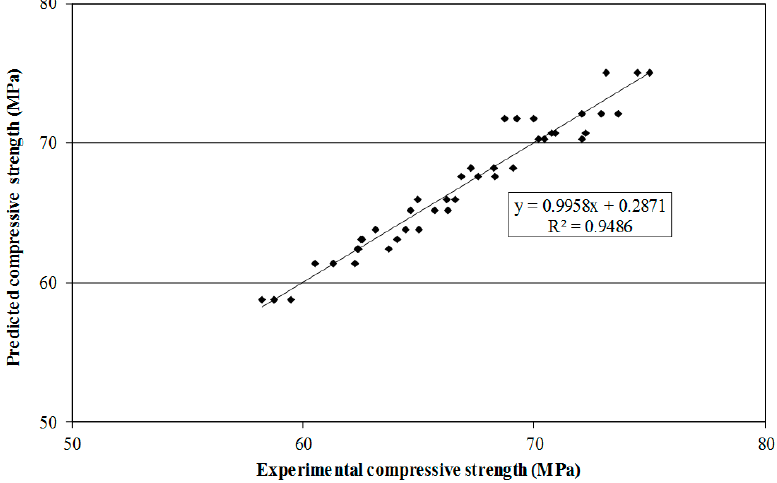
Figure 3. Comparison between experimental and predicted compressive strengths in training phase.